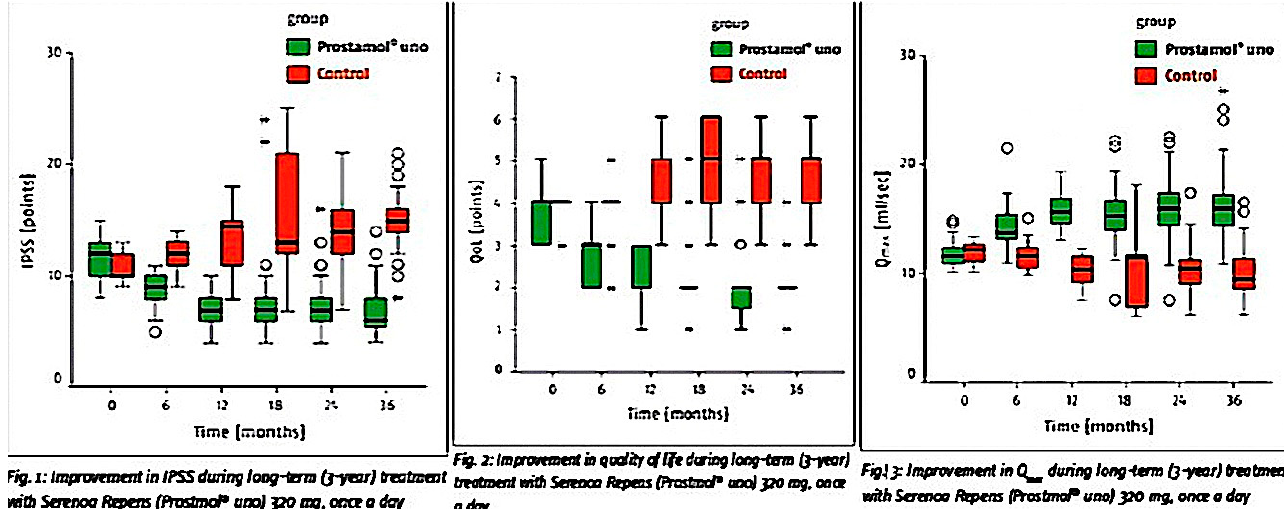
Figure 2. Changes in IPSS, QoL, and Qmax for LSESr vs. control in a 3-year intervention study. Modified after Vinarov [122] .